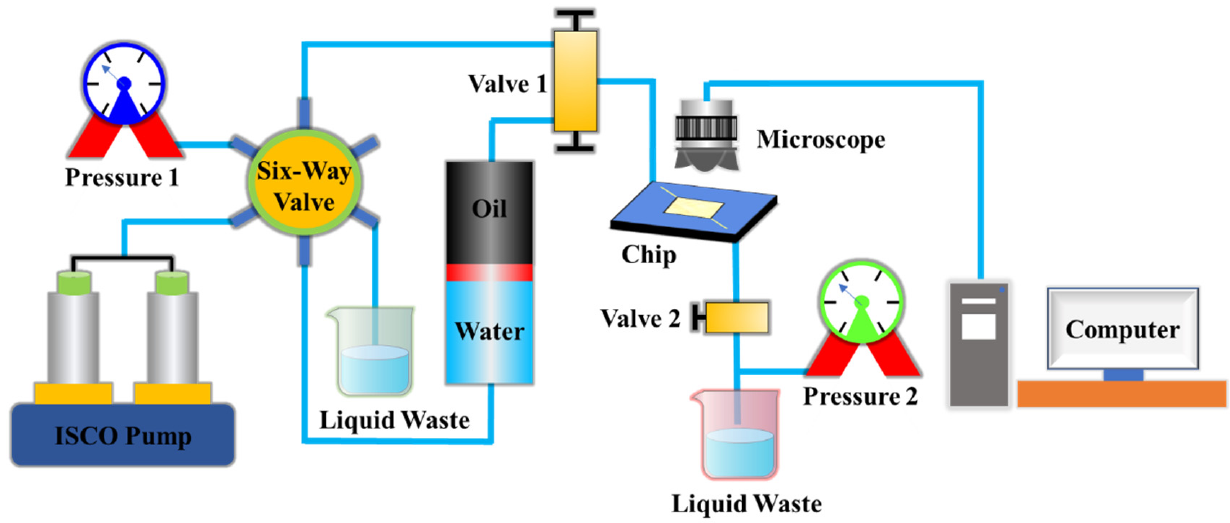
Figure 2. Schematic of the experimental setup.